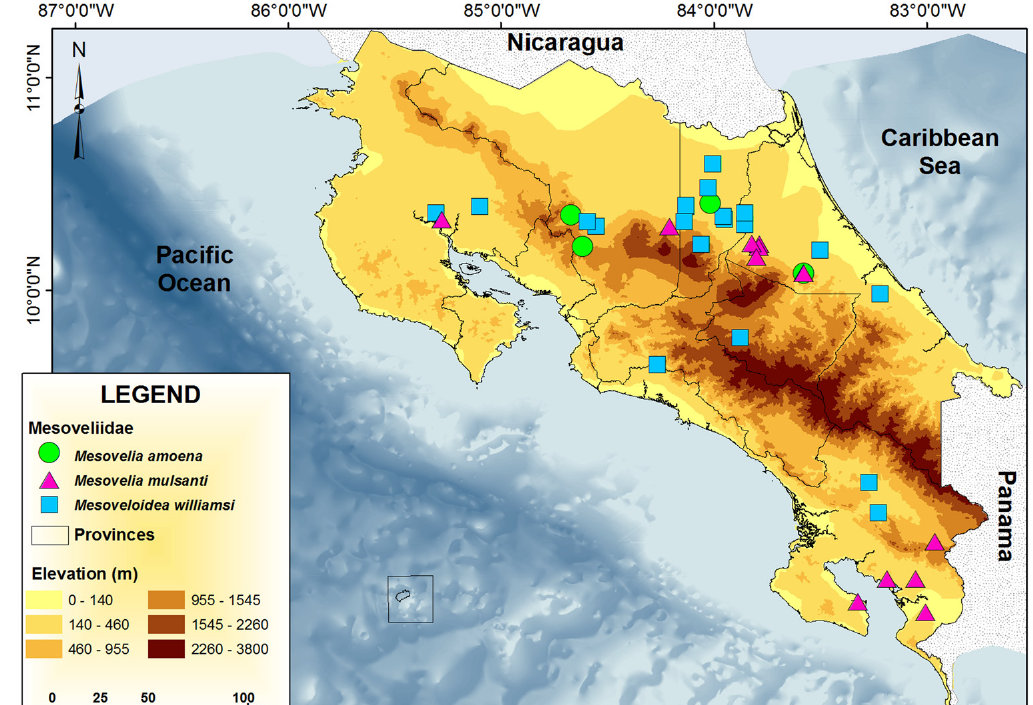
Map of Costa Rica showing the collecting localities of the family